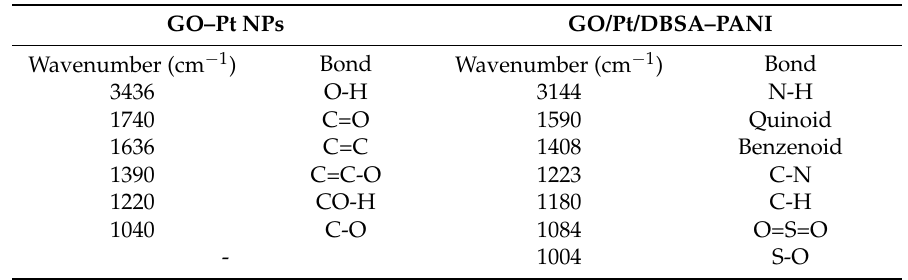
Figure 7. Fourier transform infrared (FTIR) spectra of ( a ) GO (i) and GO/Pt NPs (ii) and ( b ) GO/Pt/DBSA–PANI. Table 2. Table showing the wavenumbers and their respective bonds found in GO/Pt NPs and GO/Pt/DBSA–PANI.